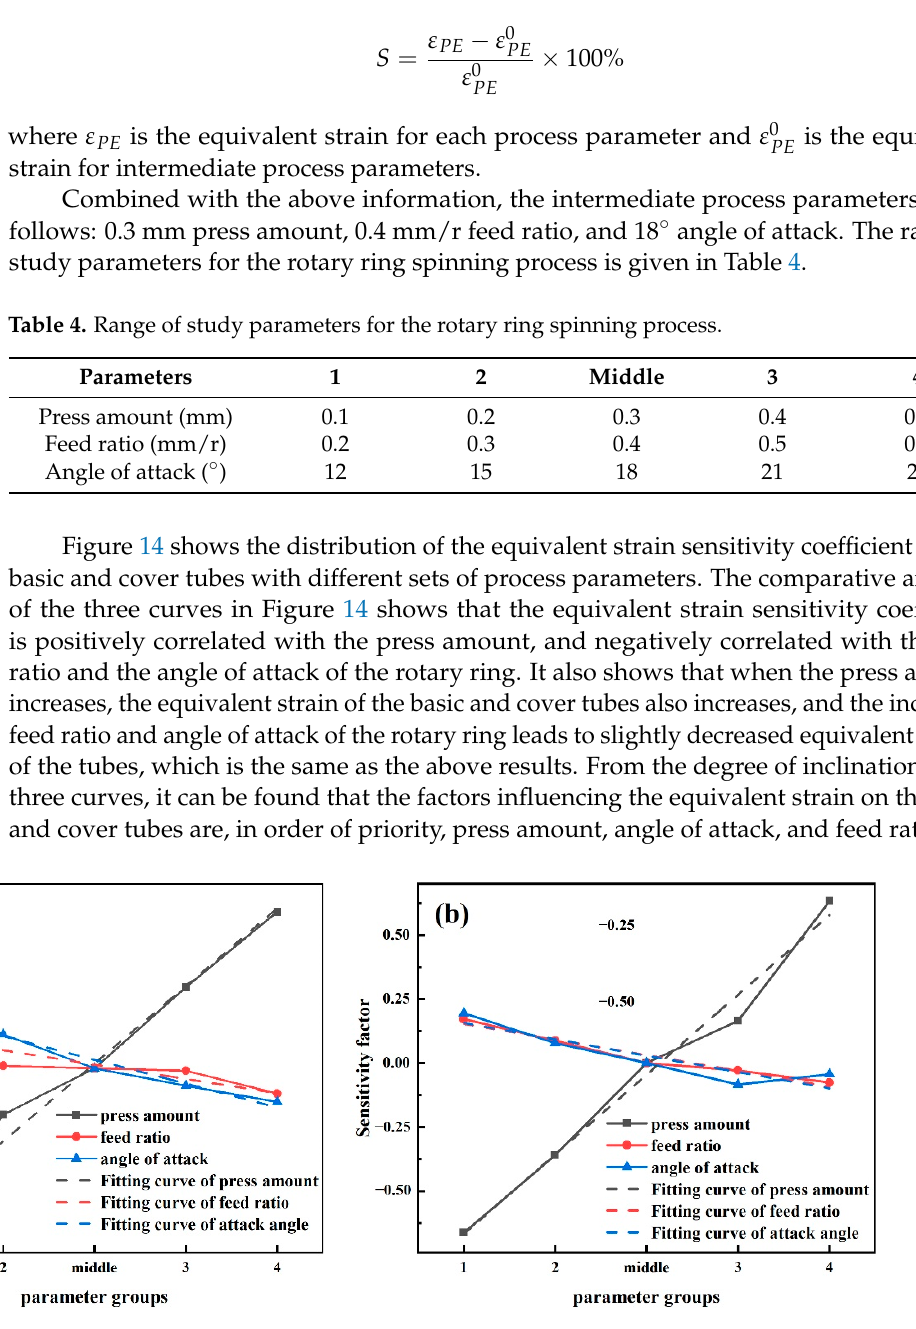
Figure 14. Distribution of the equivalent strain sensitivity coefficient for the basic and cover tubes with di ff erent sets of process parameters: ( a ) cover tube; ( b ) basic tube.